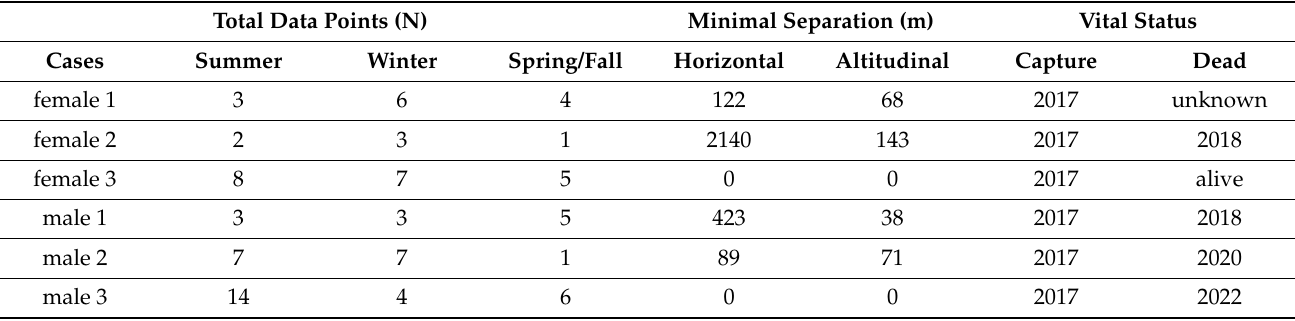
Table A1. Spatial behavior of huemul during summer and winter (precise locations based on VHF radio collars), in the Protected Park Shoonem, Chubut, Argentina, between August 2017 and April